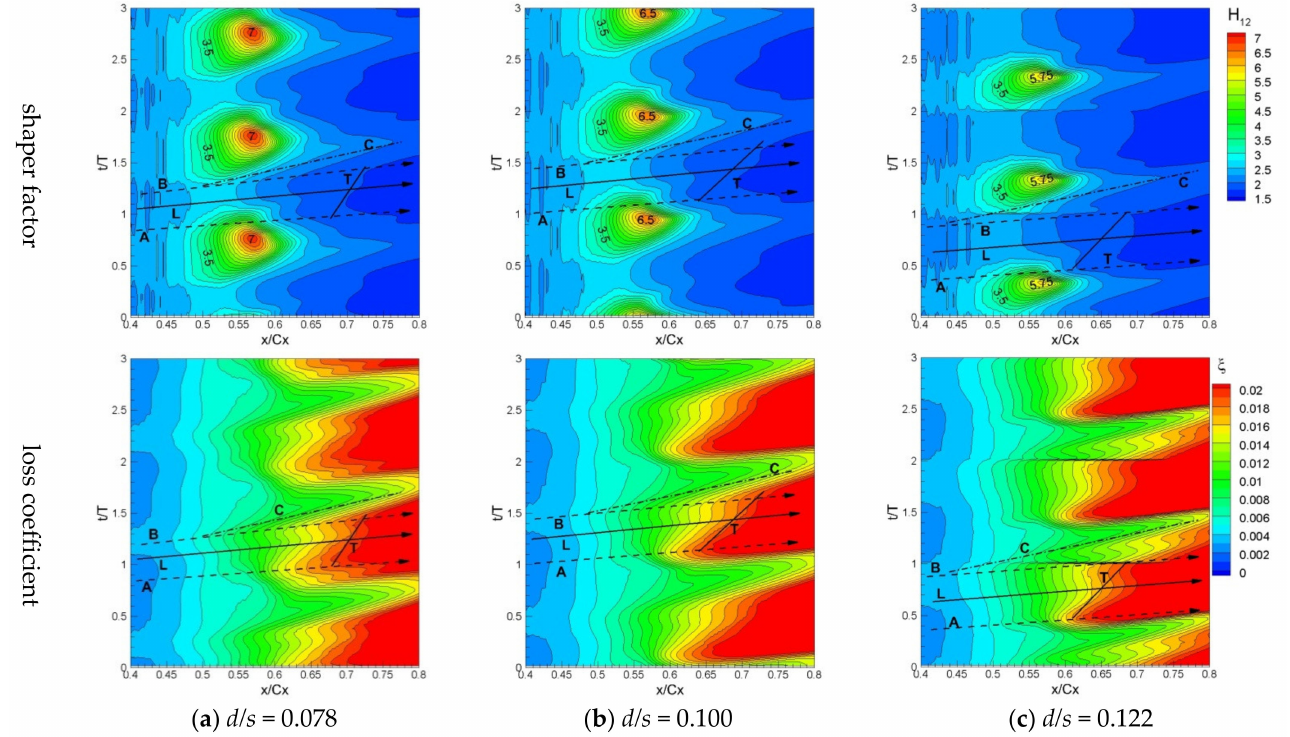
Figure 14. Space-time diagram of the boundary layer shape factor and loss coefficient when d / s = 0.078, 0.10 and